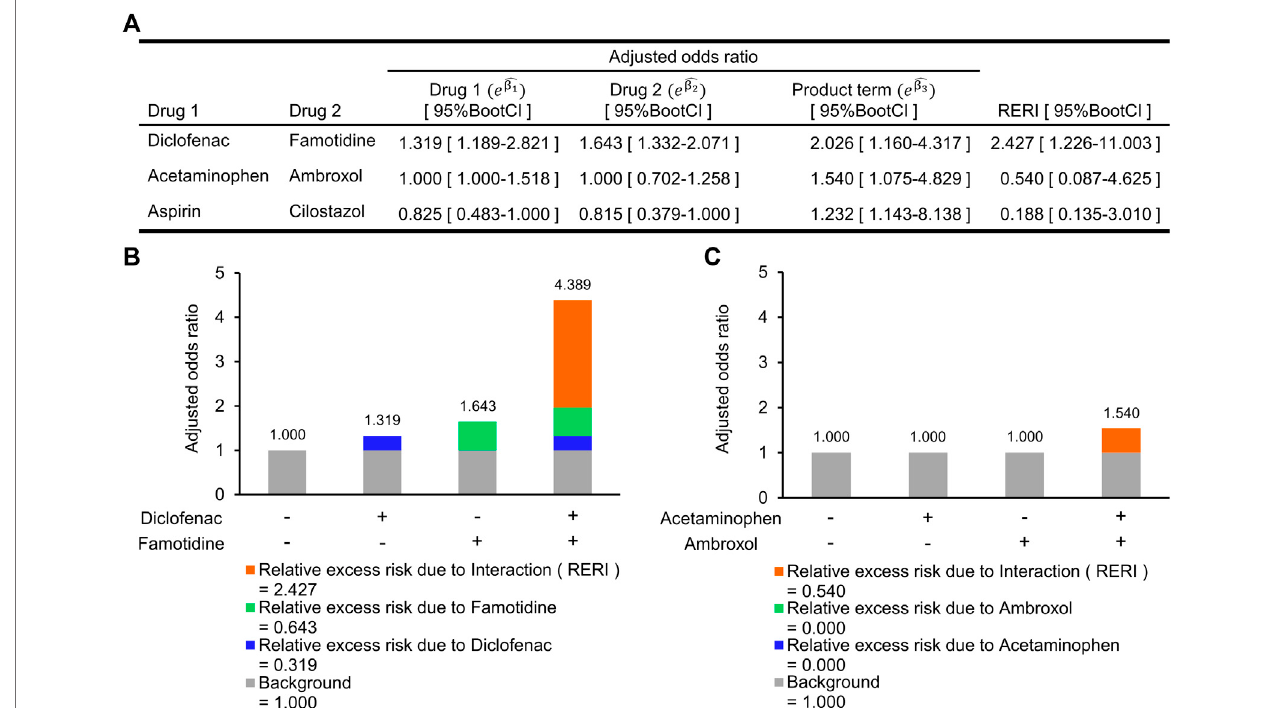
FIGURE3| Synergisticinteractionsonanadditivescalebetweentwodrugsonincreasedriskofabnormalelevationofalanineaminotransferase. (A) Adjustedodds ratio (aOR) for individual drugs and their interaction term, and a synergistic interaction measure. (B) Relative excess risk due to a combination of diclofenac and famotidine. Gray bar indicates background (i.e., non-use of diclofenac and famotidine). Blue and light green bars indicate relative excess risk due to diclofenac ( e (cid:1) β and famotidine ( e 2 − 1), respectively. Orange bar indicates relative excess risk due to interaction. (C) Relative excess risk due to a combination of acetaminophen (cid:1) β (cid:1) β (cid:1) β and ambroxol. The aOR for the combination of aspirin and cilostazol ( e 1 + 2 + 3 =0.828) was similar to the individual effects of aspirin (aOR, 0.825) and cilostazol